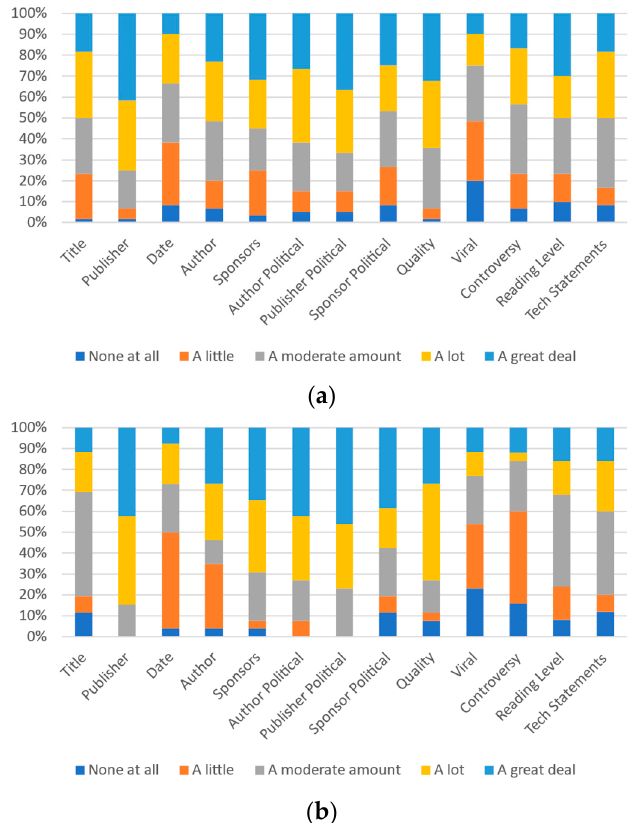
Figure 9. Participants’ responses on the magnitude of each category’s effect on self-perception: ( a ) 18–29 and ( b ) 30+.